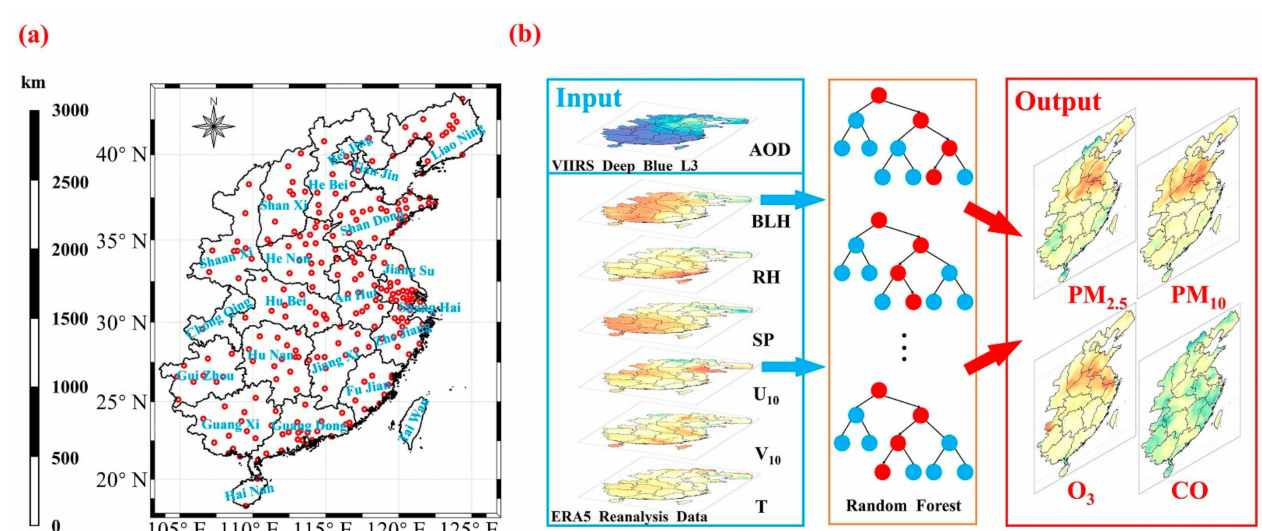
Figure 1. ( a ) Study area, including 22 provinces and air quality monitoring stations (red dots) in the central and eastern China; ( b ) Schematics of geographical random forest (RF)